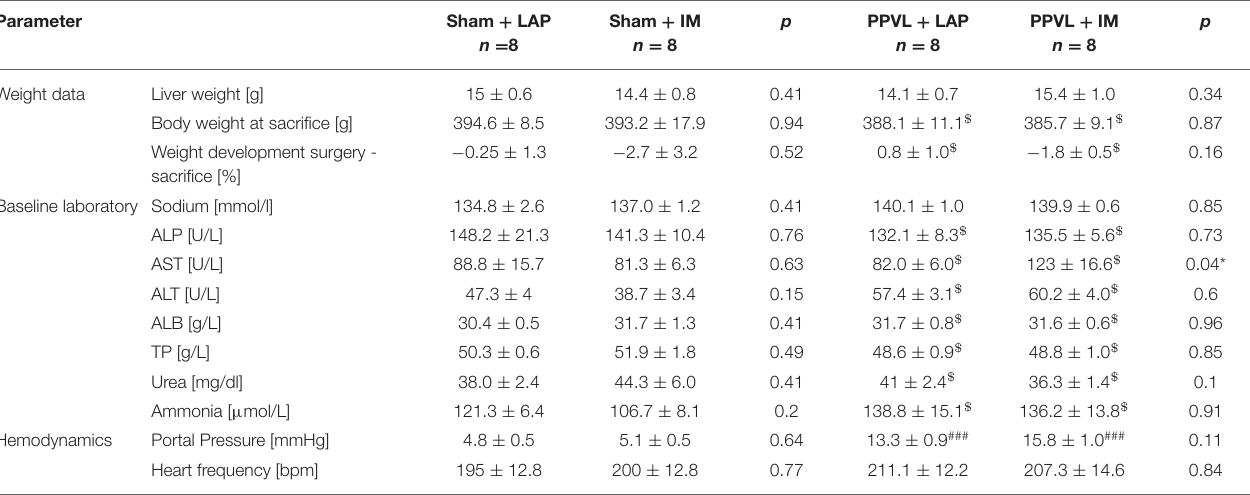
TABLE 1E | General characteristics and clinical data of rats undergoing Sham/PPVL at sacrifice 2 days after IM/LAP. Parameter p